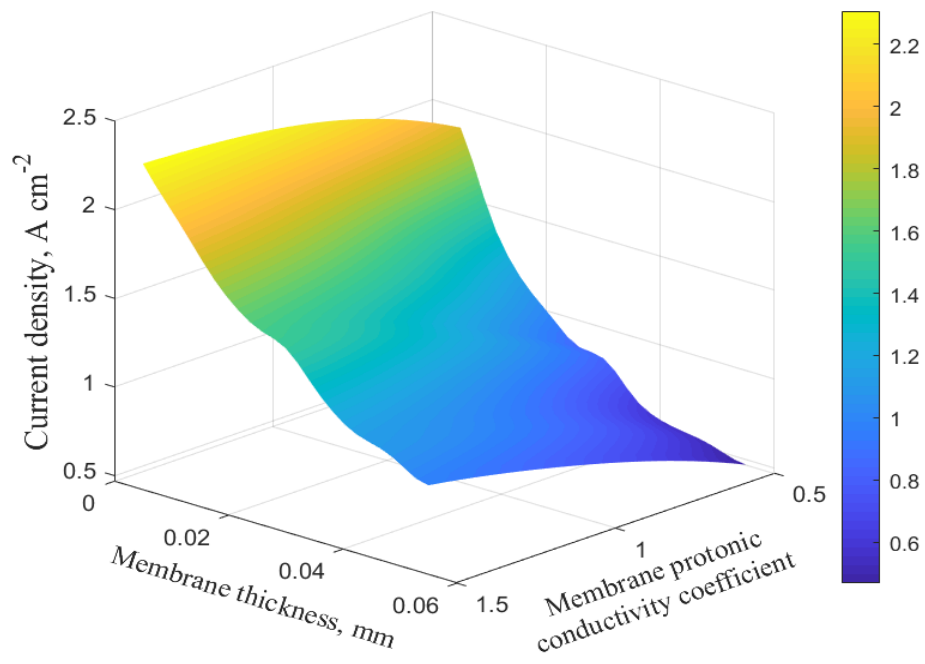
Figure 9. Three-dimensional response surface plot at 0.6 V. Figure 10. Three-dimensional response surface plot at 0.8